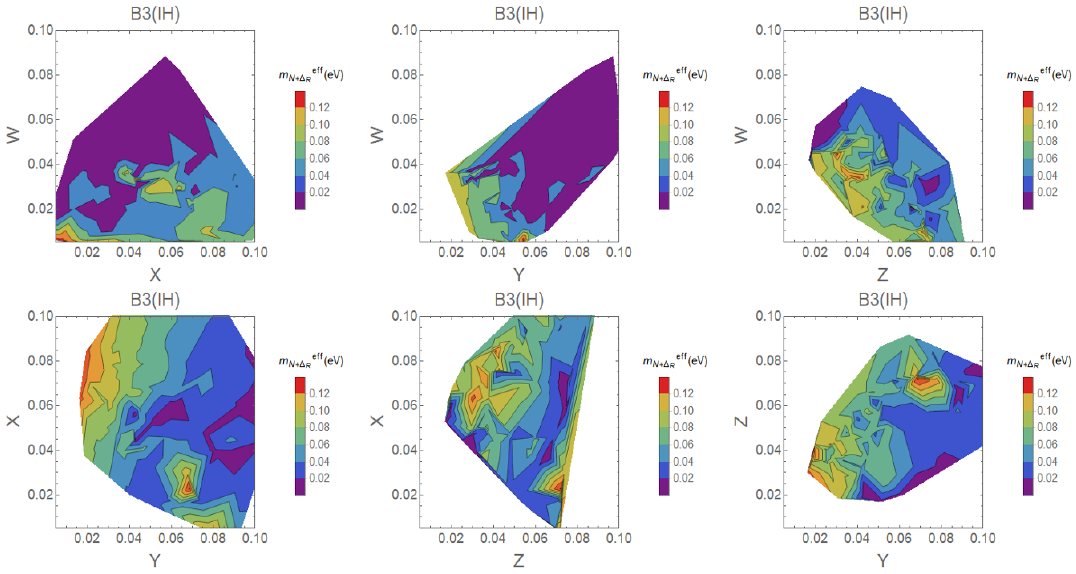
JHEP02(2019)129